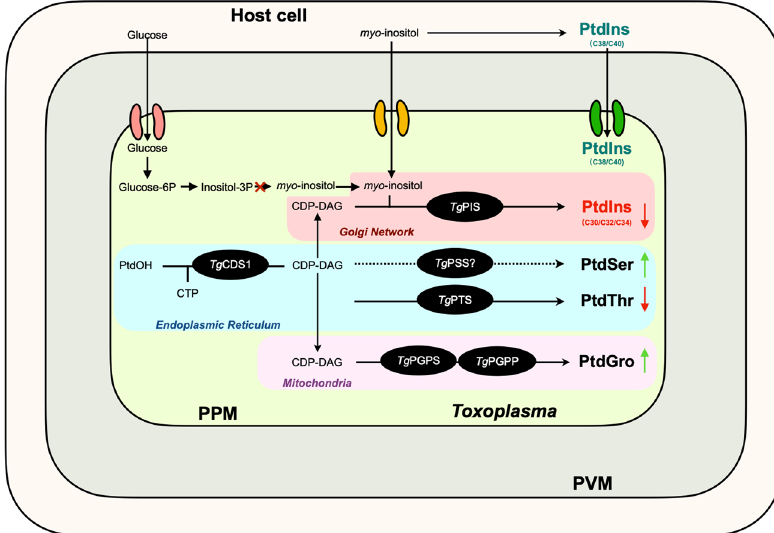
Fig. 9 Model of PtdIns biosynthesis and homeostasis of anionic phospholipids in T. gondii . PtdIns is made by Tg PIS in the Golgi network using CDP-DAG and myo -inositol. CDP-DAG is generated by Tg CDS1 in the endoplasmic reticulum, whereas myo -inositol is imported from the milieu. De novo synthesis of myo -inositol involves conversion of glucose to glucose-6-phosphate by hexokinase, followed by the action of inositol-3P synthase to produce inositol-3- phosphate. Successively, Ins3P is dephosphorylated to make inositol by inositol-3P monophosphatase. There is no biochemical and genetic evidence for the latter enzyme in T. gondii . Knockdown of Tg PIS reduces the level of many PtdIns species along with homeostatic modulation of other anionic lipids (namely PtdThr, PtdSer, PtdGro species). PtdIns species with shorter chains (e.g., C30/C32/C34) are synthesized de novo, while PtdIns species with relatively longer acyl chain (C38/C40) are salvaged by the parasite from its host cell. Based on isotope labeling studies, we speculate that both routes contribute to the synthesis of C36 PtdIns species (not shown). Transporters, inter-organelle contact sites, or other lipid traf fi cking pathways, as stated, enable transport of myo -inositol and CDP-DAG. The question-marked reaction speci fi es yet-unknown enzyme involved in CDP-DAG-dependent PtdSer synthesis. Selected abbreviations: CDS, CDP-DAG synthase; PGPS, PtdGro phosphate synthase; PGPP, PtdGro phosphate phosphatase; PSS, PtdSer synthase; PTS, PtdThr synthase; PPM, parasite ’ s plasma membrane; PVM, parasitophorous vacuole